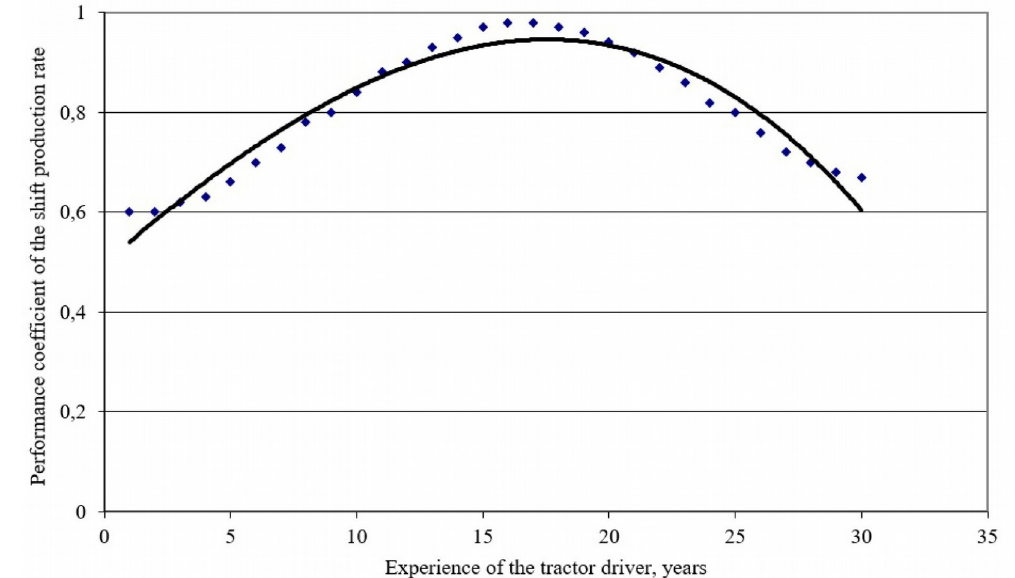
Figure 2. The dependence of the performance coefficient of the shift production rate on the experience of the tractor